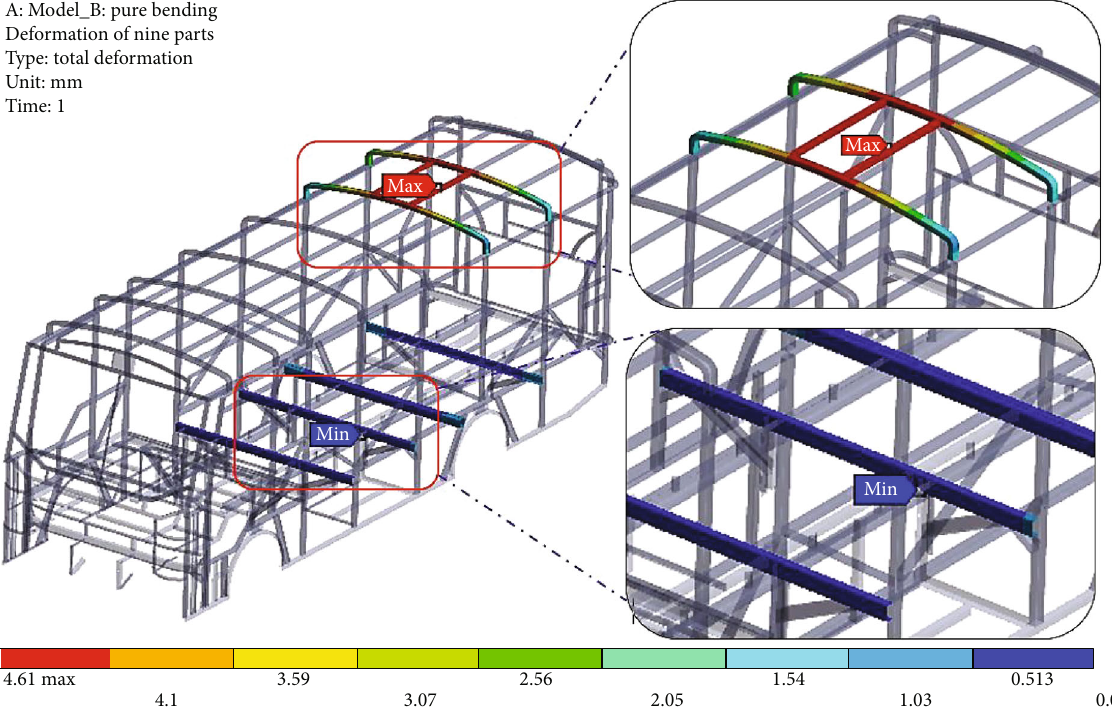
Figure 10: Preliminary FE results of the reinforced structure on the fl oor and roof sections.